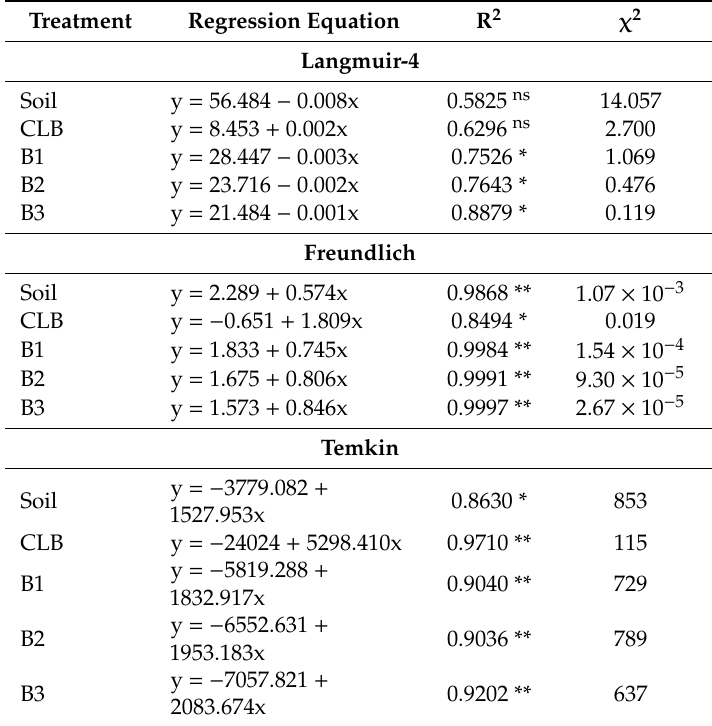
Table 15. Regression equations, Coe ffi cient of determination (R 2 ), and Chi-square analysis ( χ 2 ) for the fit of the Langmuir type 4, Freundlich, and Temkin isotherms to the phosphorus adsorption data of the treatments.